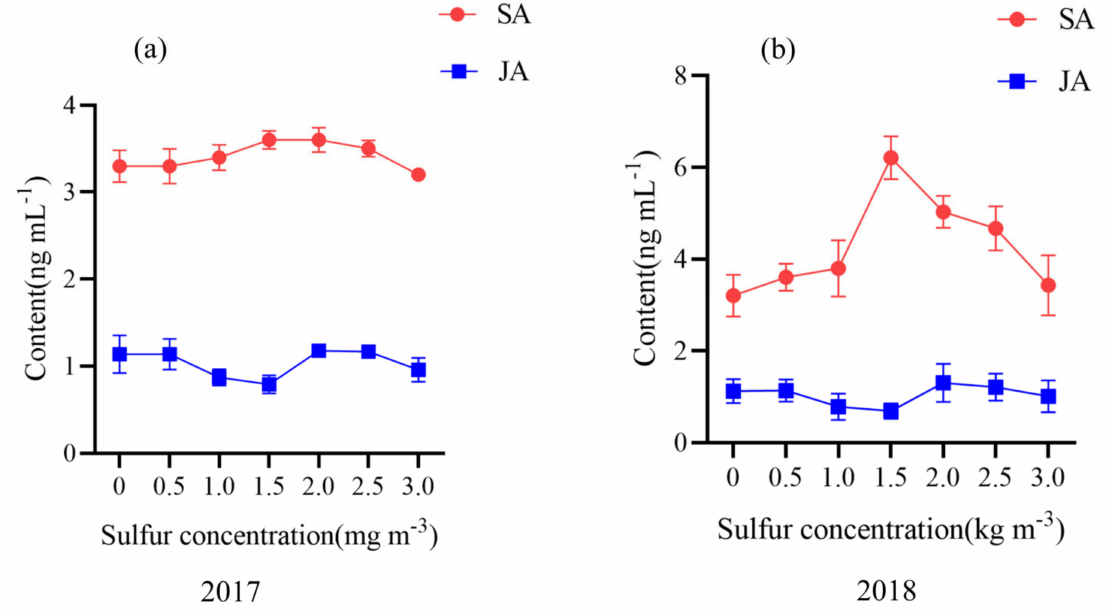
Figure 4. Effect of sulfur on salicylic acid and jasmonic acid content. Abbreviations: SA, salicylic acid; JA, jasmonic acid. Value are means ± SE (n = 3). ( a ) Contents of salicylic acid and jasmonic acid in kiwifruit leaves in 2017; ( b ) Contents of salicylic acid and jasmonic acid in kiwifruit leaves in